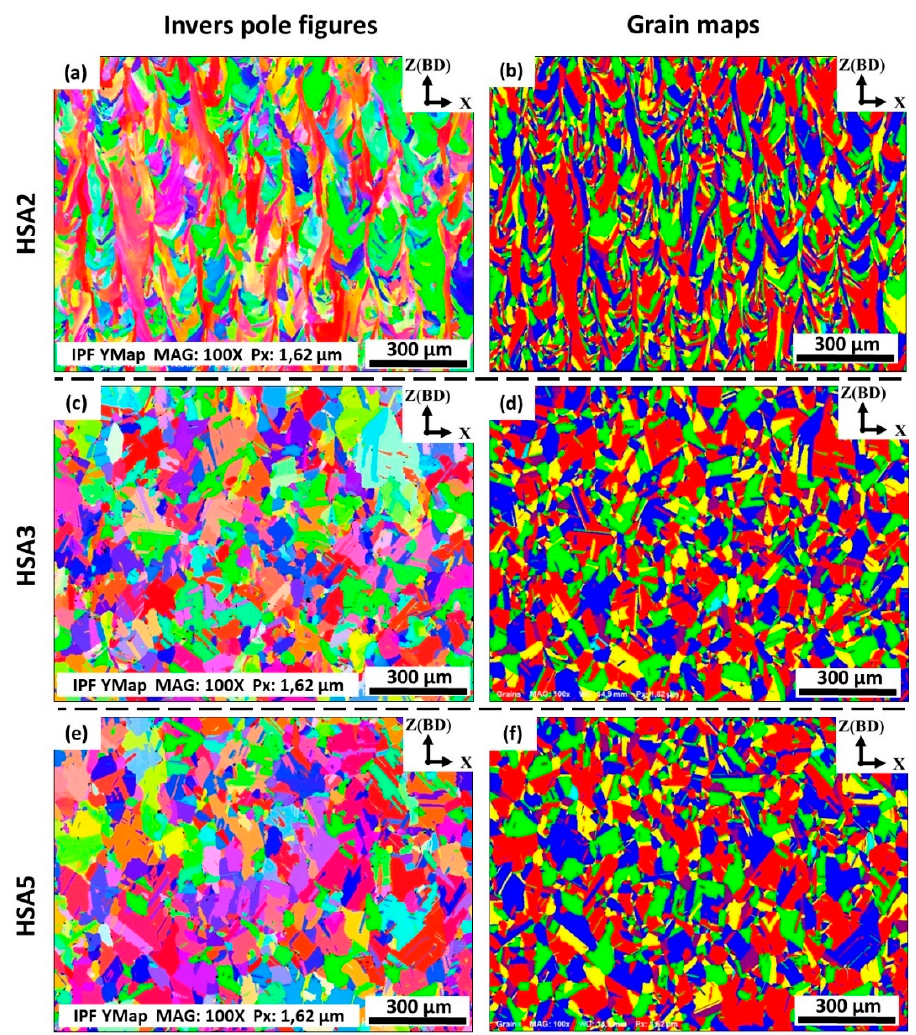
Figure 14. The EBSD inverse pole figures ( a , c , e ) and grain maps ( b , d , f ) in the xz-plane of laser powder bed fused IN718 specimens in conditions: ( a , b ) HSA2; ( c , d ) HSA3 and ( e , f ) HSA5. For the IPF color legend, please refer to that presented in Figure 8. All the EBSD crystallographic orientation maps were plotted using the y-based projected IPF.